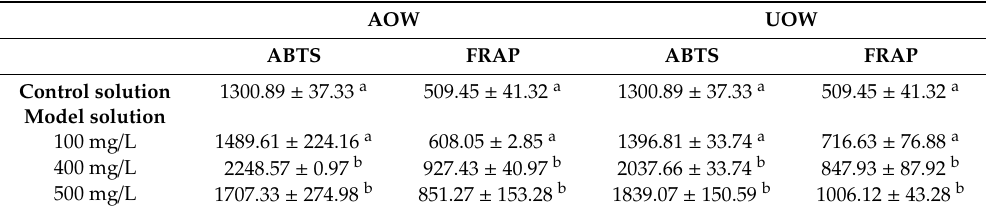
Table 4. Antioxidant activity of the control and model solutions with di ff erent TPC from American (AOW) and Ukrainian (UOW)